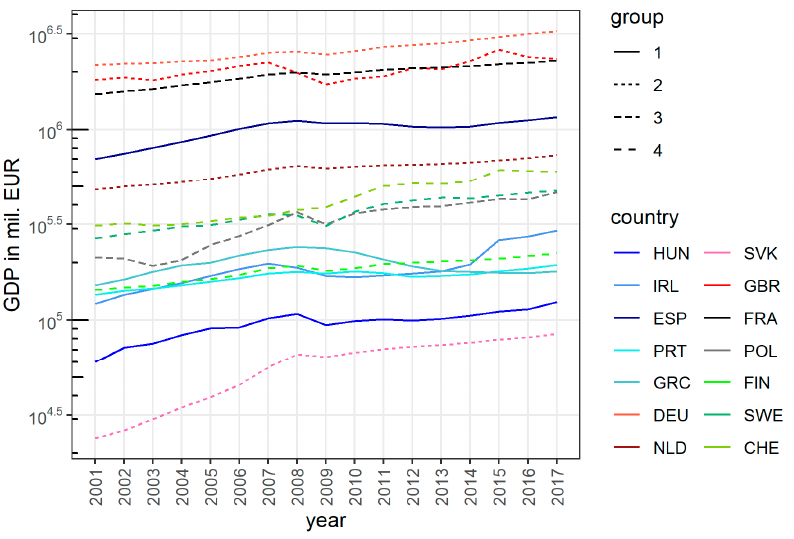
Figure 1. The development of the GDP in analyzed countries.